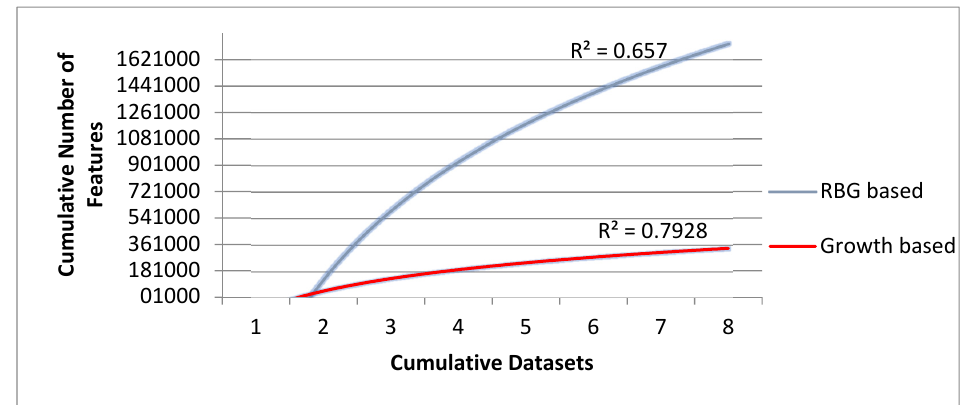
Figure 6. Trending Analysis of how the number of features grow as the number of datasets increase.